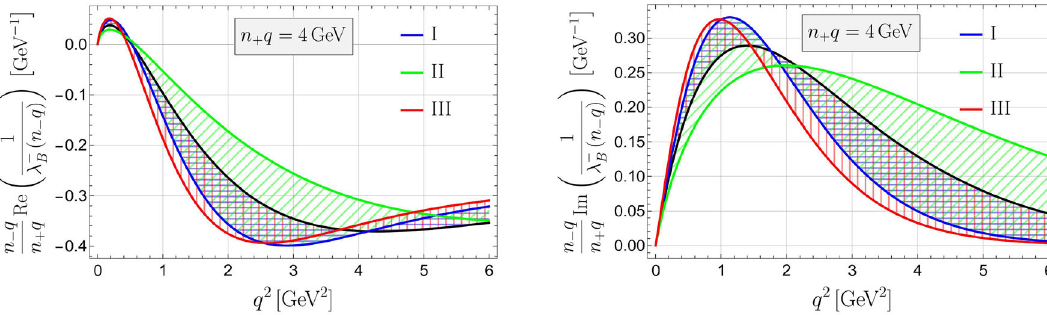
Fig. 9 As Fig. 8 but for n − q